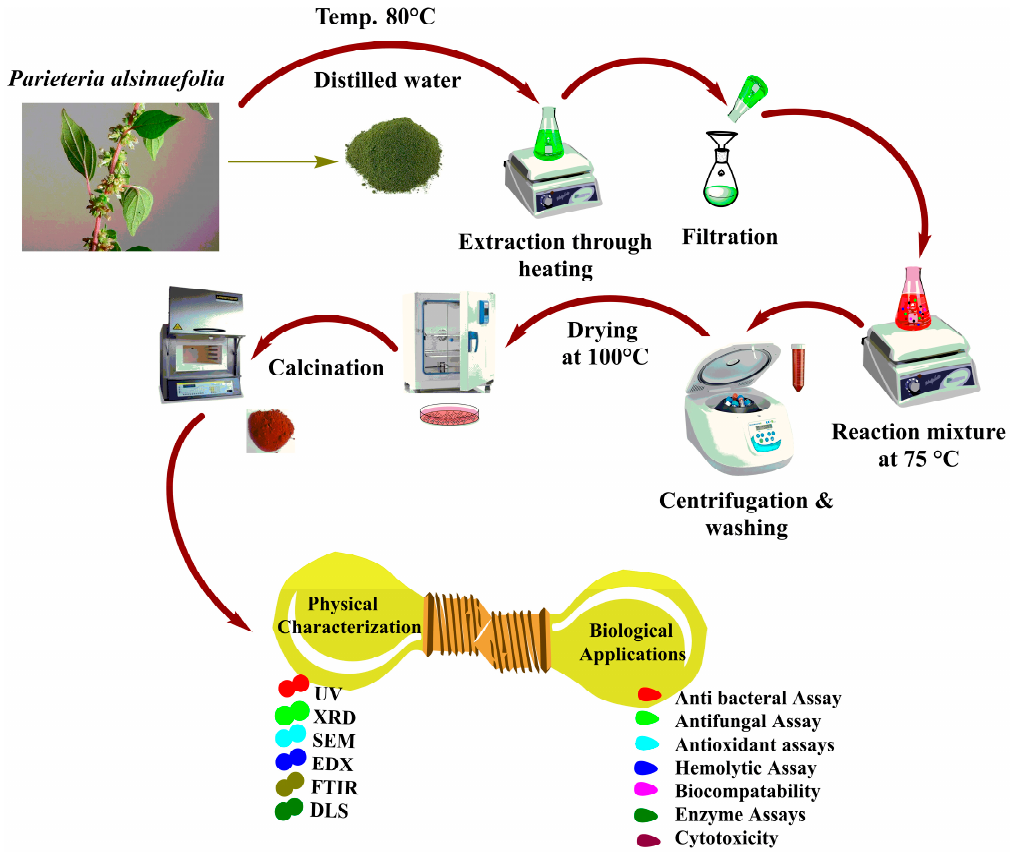
Figure 1. The detailed mechanism of P . alsinaefolia mediated Ag 2 ONPs synthesis.